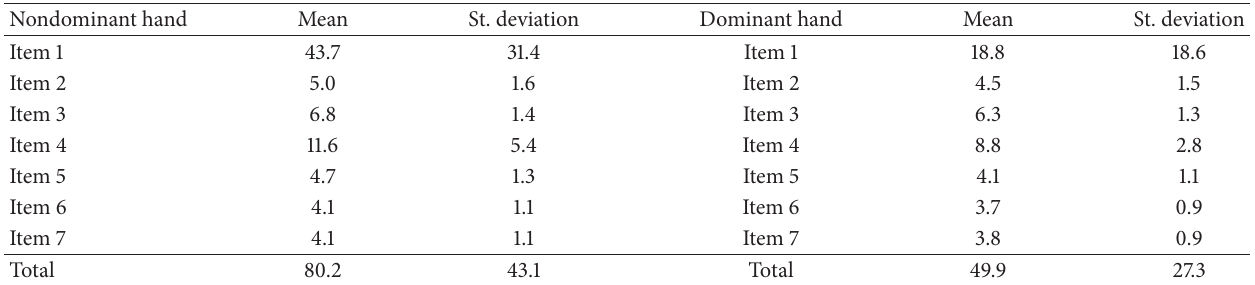
Table 5: Mean of time and SD.